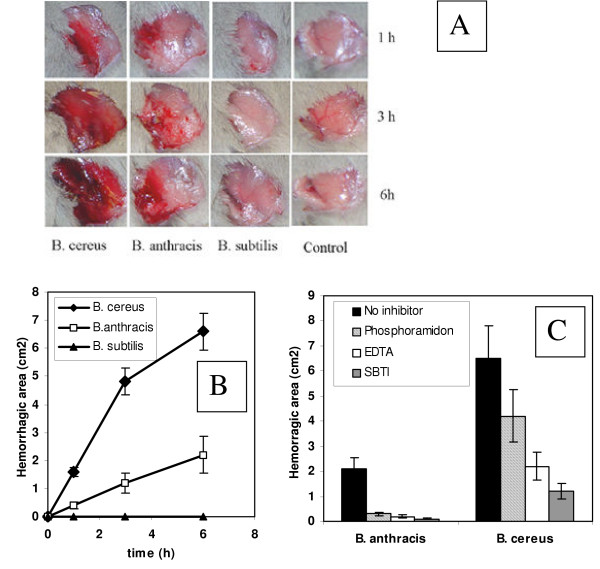
Hemorrhagic activity of culture supernatants (A), its graphic representation (B) and inhibition with chemical inhibitors (C). 100 μl of secreted proteins (20 to 100 μg) were subcutaneously (sc) injected into the femoral artery region for observation of hemorrhagic changes. The fur over the femoral artery region was removed to allow observation of a 1.5 to 2.5 cm2 area of skin. Control mice were administered equal amount of phosphate-buffered saline. Error bars indicate standard deviations.